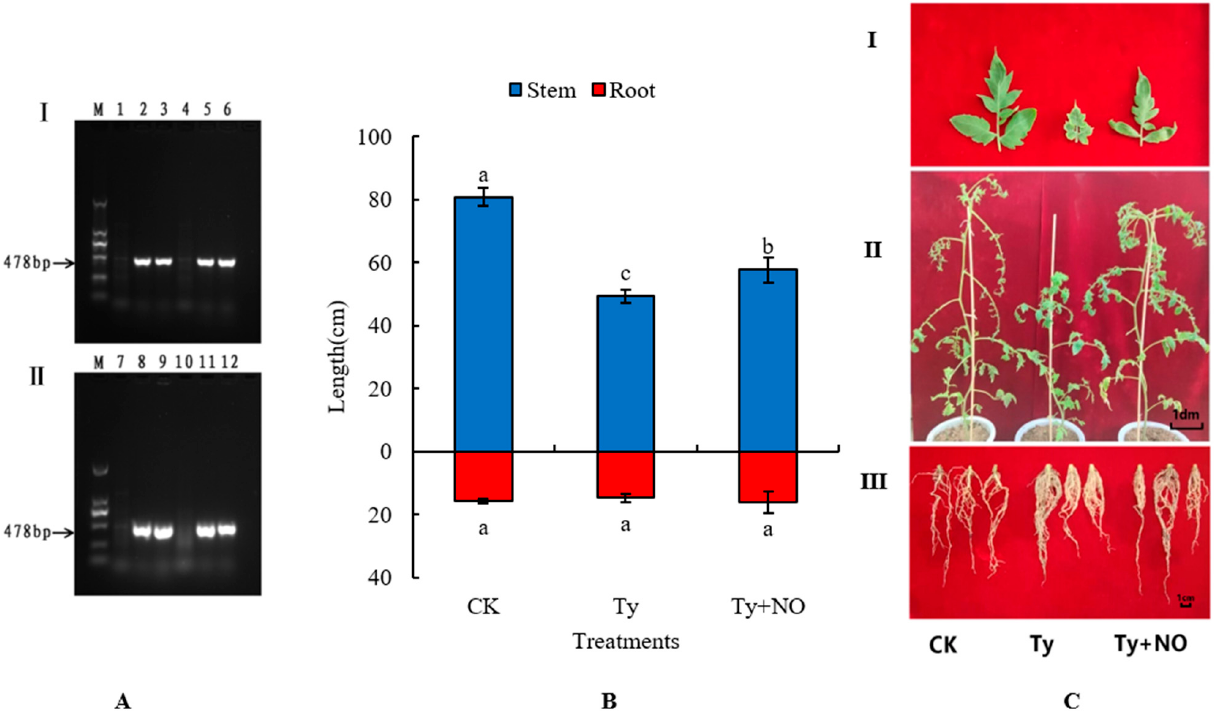
Figure 1. Changes in tomato inoculation and performance 30 d after inoculation. ( A ) TYLCV assay results at 9 d and 36 d after TYLCV inoculation. I and II indicate virus detection at day 9 and day 36 after inoculation, respectively. In 1–6 is indicated the detection results on day nine after virus inoculation, where 1 and 4 indicate the control group and 2, 3, 5, and 6 indicate the virus-inoculated group. In 7–12 is indicated the detection results on day 36 after virus inoculation, where 7 and 10 indicate the control group and 8, 9, 11, and 12 indicate the virus-inoculated group. ( B ) Effect of exogenous NO on plant height and root length at 30 d after tomato susceptibility. Different lowercase letters in the graph indicate significant differences ( p < 0.05), the same below. ( C ) Effect of exogenous NO on phenotype at 30 d after tomato susceptibility. I, II and III indicate the effects of exogenous NO on leaves, stems and roots of virus-infected tomatoes, respectively.